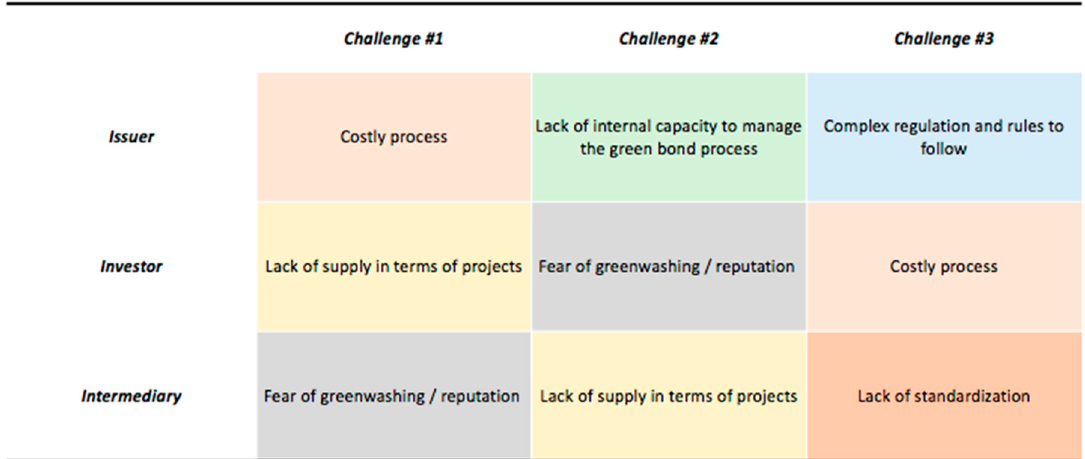
Figure 4. Top three challenges faced by category of green bond market participants. Source: based on interviews with 11 experts across issuers, investors, and intermediaries, conducted in December 2019.